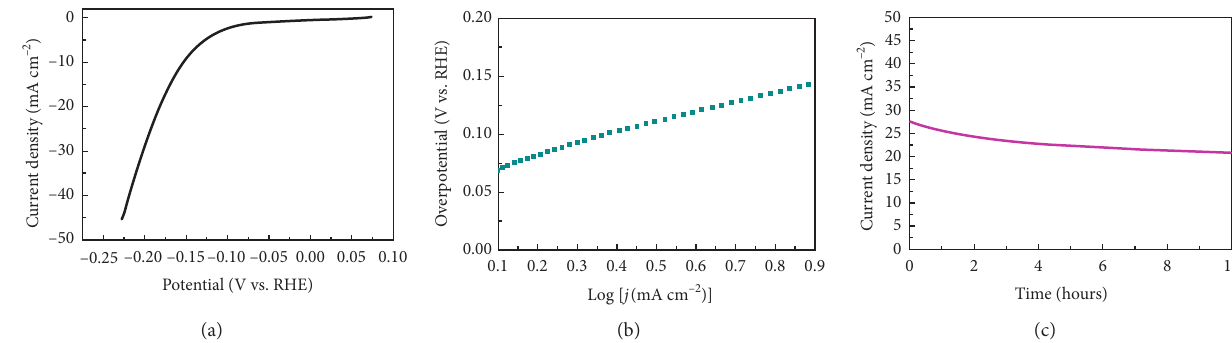
Figure 7: (a) Polarization curves and (b) Tafel plots calculated from polarization curves of the Ni room temperature with a scan rate of 5mV · s − 1 . (c) Chronoamperometric profile of the electrode measured at − 200mV in 0.5M · H 2 SO 4